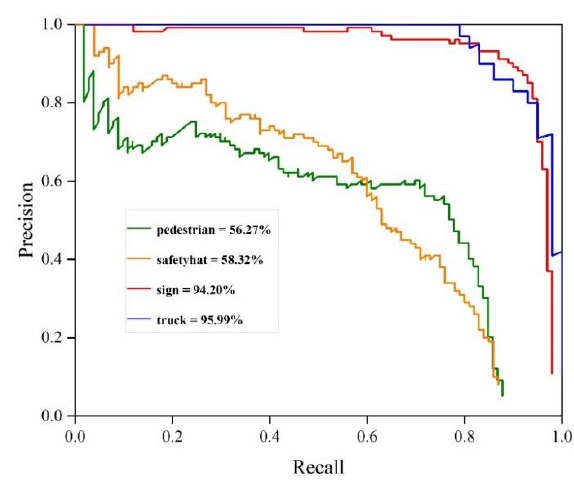
Figure 7. AP of the model.